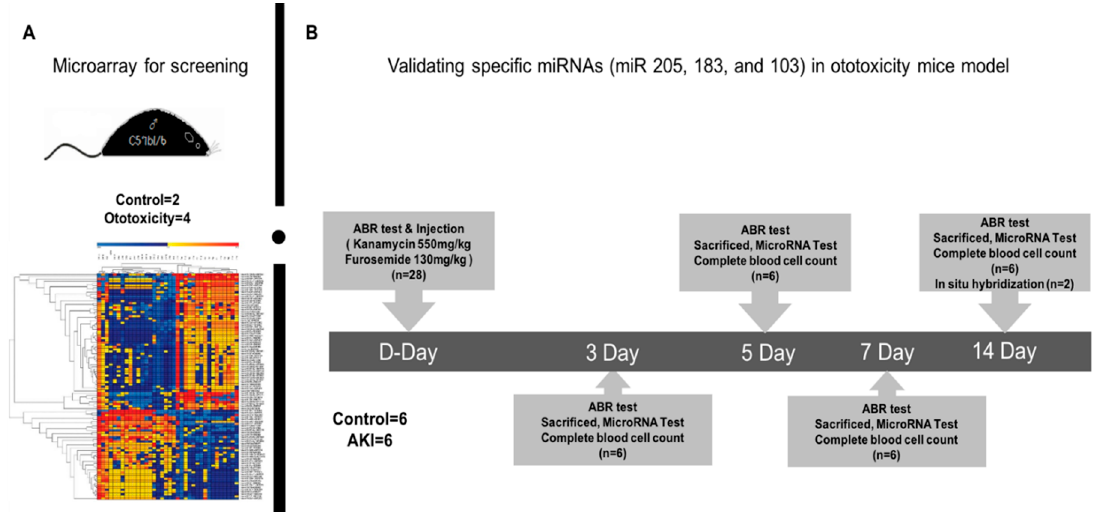
Figure 5. Scheme for verifying specific miRNAs in the ototoxicity-induced mouse model. ( A ) To screen specific miRNAs in ototoxicity-induced mice, 3165 miRNAs were identified, hierarchical clustered, and the expression levels were graphically displayed. The process for establishing the ototoxicity-induced mouse model for 14 days is shown. ( B ) During the 14 days, mice were tested with hearing thresholds by an auditory brainstem response test, and levels of circulating miR-205 and miR-183 compared to miR-103 in the serum and cochlea are shown, as well as the local expression pattern of miR-205 by in situ hybridization.